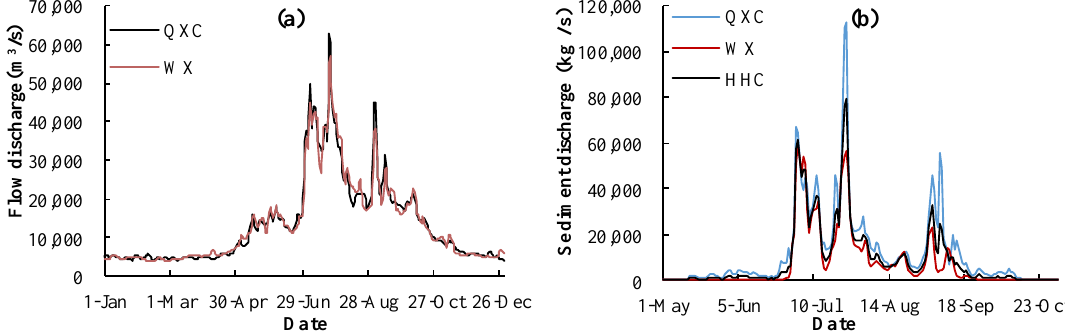
Figure 2. Planform geometry, bed elevation ( Z 0 ) on March 2012 and nine cross-sections measured in HHC reach (S209 and S201 are the inlet and outlet boundaries, respectively; incoming flow discharge and sediment concentration used as inlet boundaries are interpolated from Qingxichang and Wanxian gauging station, located upstream 476.46 km and 291.38 km from TGP, respectively; and the outlet boundary applies the water stage measured at Shibaozhai station, located upstream 341.35 km from the TGP).